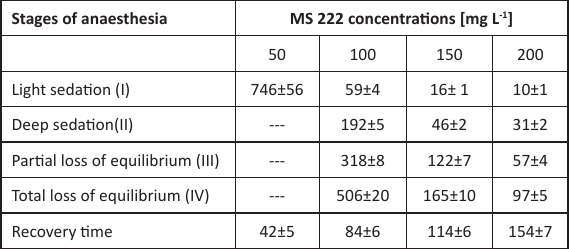
Table 3. Timing (seconds) of anaesthesia and recovery phases in Puntius denisonii exposed to various MS-222 concentrations (mean±S.D)